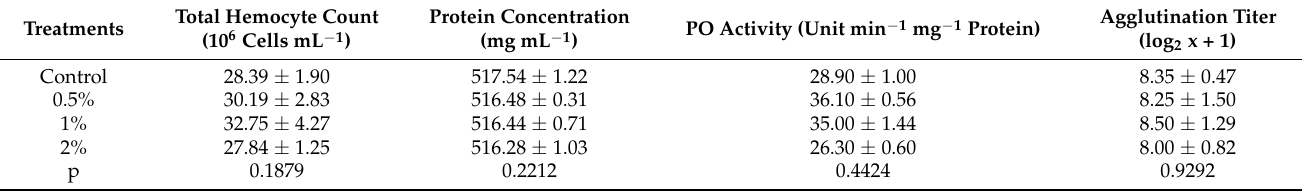
These data represent average ± standard deviation of n = 4. No statistical difference was observed among treatments ( p ≥ 0.05).